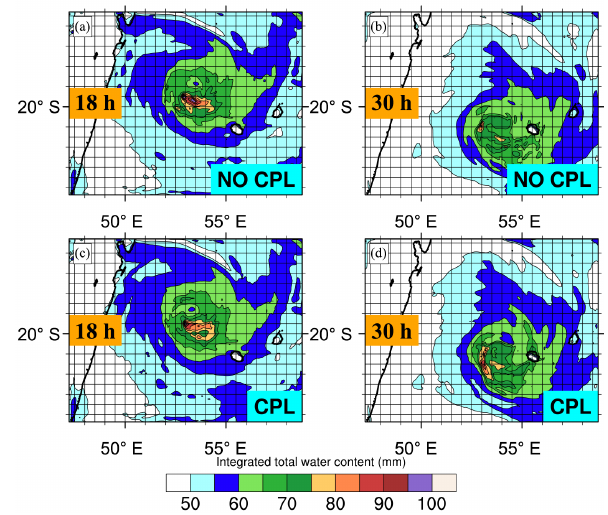
Figure 7. Total integrated water content in millimetres after 18h (a, c) and 30h (b, d) of simulation, respectively. The top pan- els (a, b) show results for the non-coupled system (NOCPL, i.e atmosphere-only) and the bottom panels (c, d) show results for the coupled system